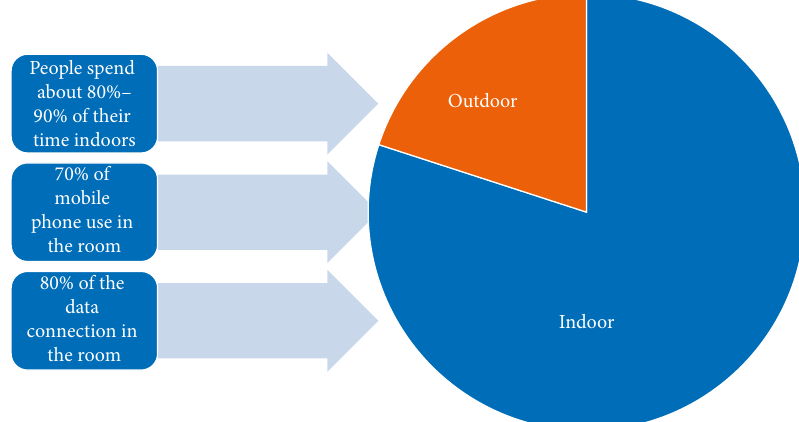
Figure 1: Distribution of people’s activities: indoor and outdoor